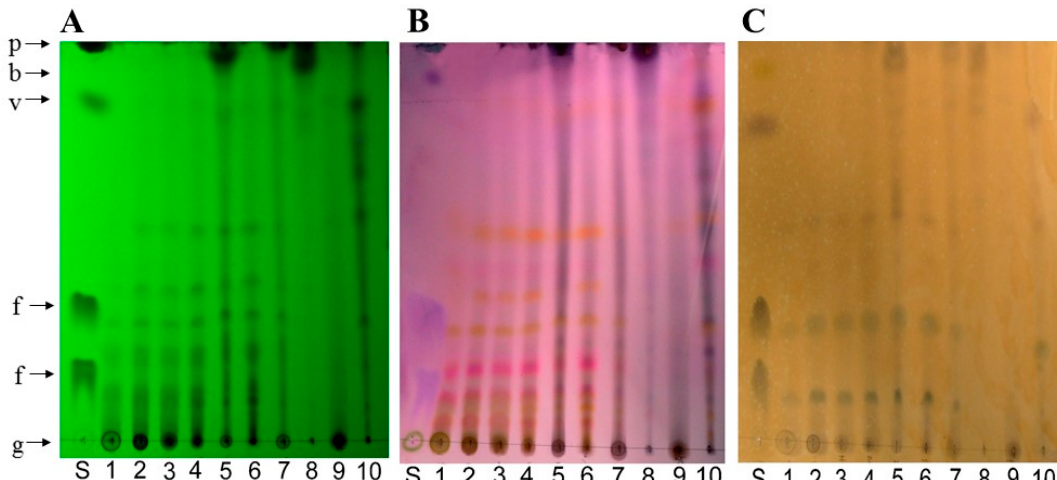
Figure 2. TLC plate demonstrating the phytochemical profile of quaking aspen. TLC was executed using three revelation methods: ( A ) UV light at 254 nm; ( B ) p -anisaldehyde reagent; ( C ) iron chloride (FeCl 3 ). The different extracts (1–10) represent quaking aspen extracts with different extraction solvents. From left to right: (1) water, (2) methanol, (3) ethanol, (4) acetone, (5) methylene chloride, (6) ethyl acetate, (7) chloroform, (8) hexane, (9) water-ethanol, (10) acid-base extract. (S) corresponds to a standard mix of glucose (g), ferrulic acid (f), vanillin (v), betulin (b) and piperine (p) with their respective localisation on TLC.